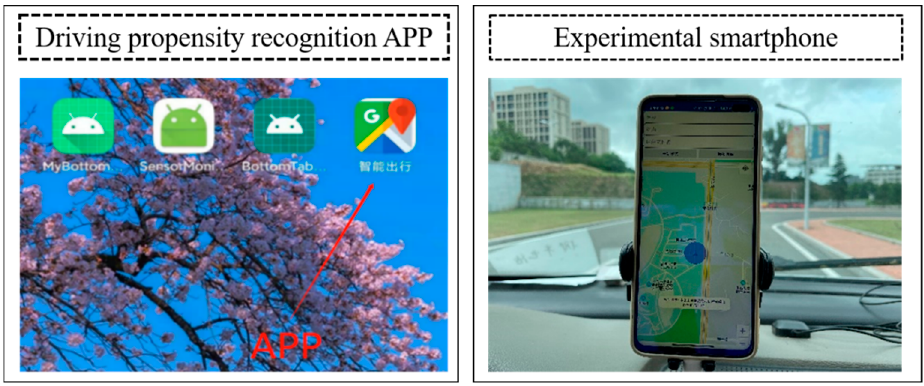
Figure 11. Driving propensity recognition APP and experimental smartphone.